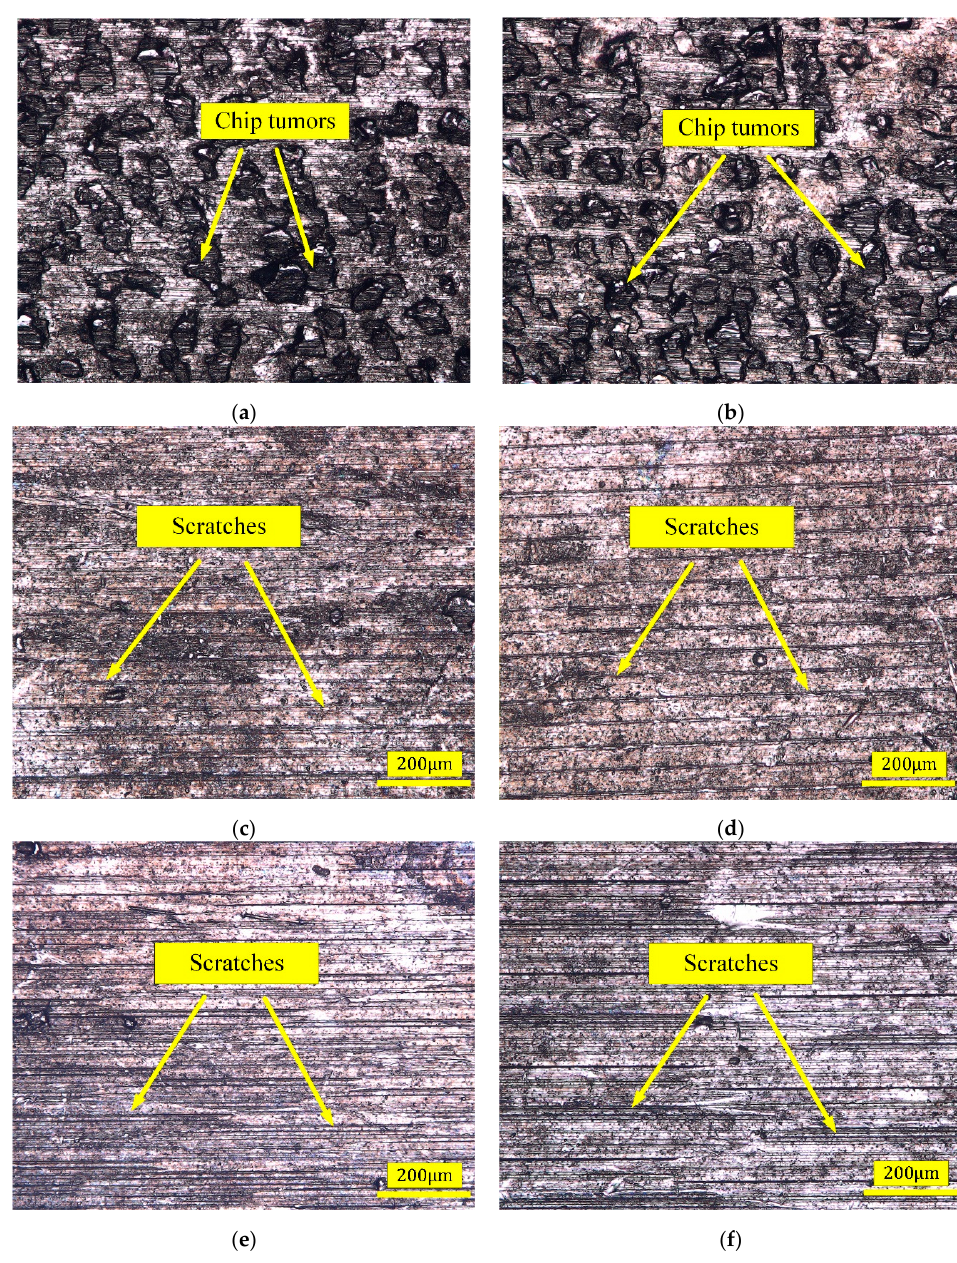
Figure 6. Microscopic morphology of the machined surface after multi-pass turning: ( a ) single-pass turning of T1, ( b ) single-pass turning of T2, ( c ) double-pass turning of T6, ( d ) double-pass turning of T7, ( e ) triple-pass turning of T11, and ( f ) triple-pass turning of T12.